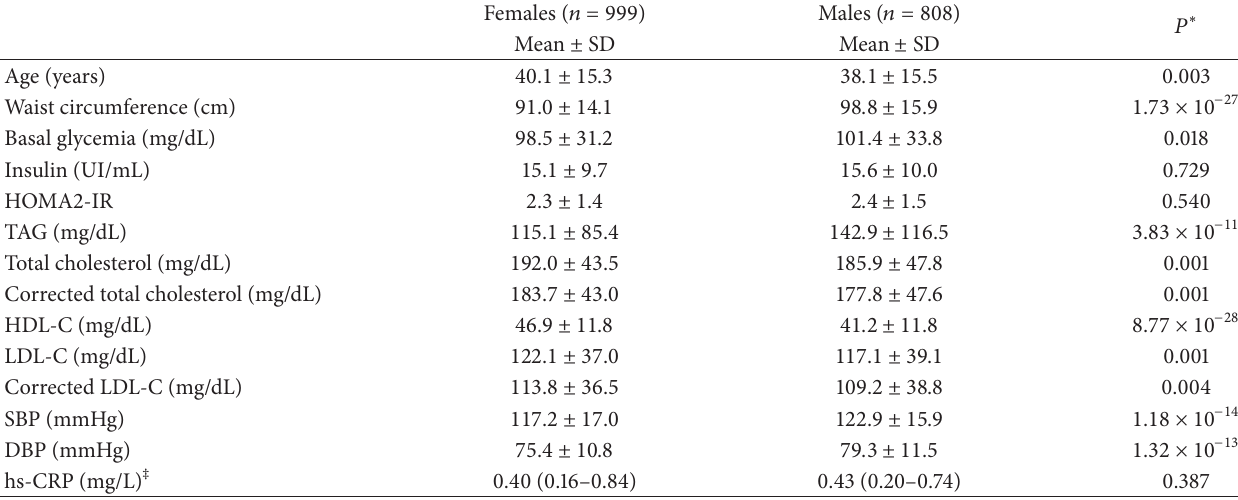
Table 2: Clinical and biochemical parameters evaluated by gender. The Maracaibo City Metabolic Syndrome Prevalence Study, 2013.